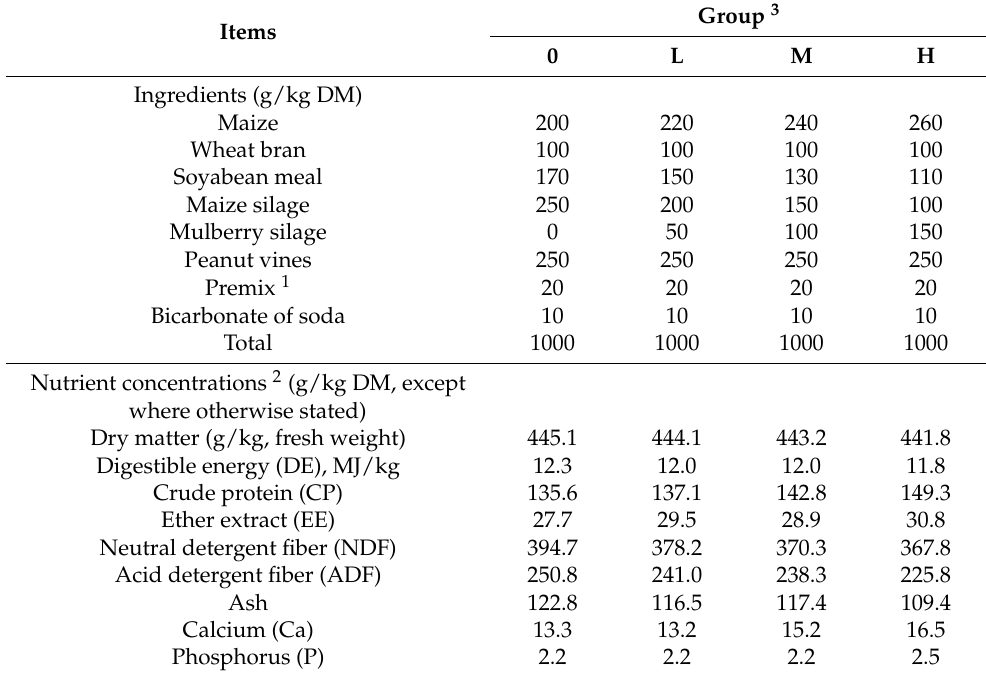
Table 1. Ingredients and chemical compositions of experimental